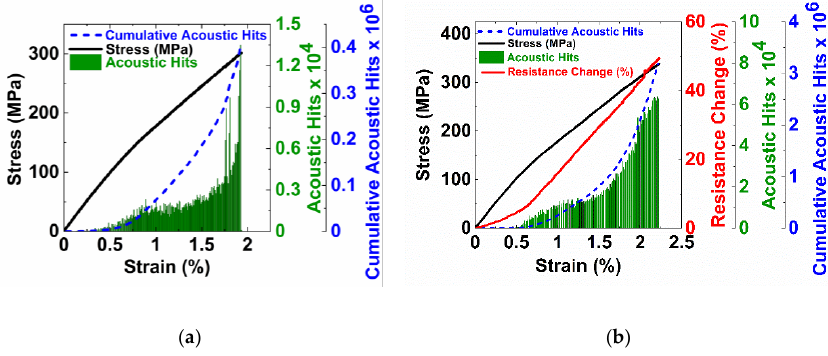
Figure 5. Monotonic testing was completed on the specimens both ( a ) without carbon nanotubes and